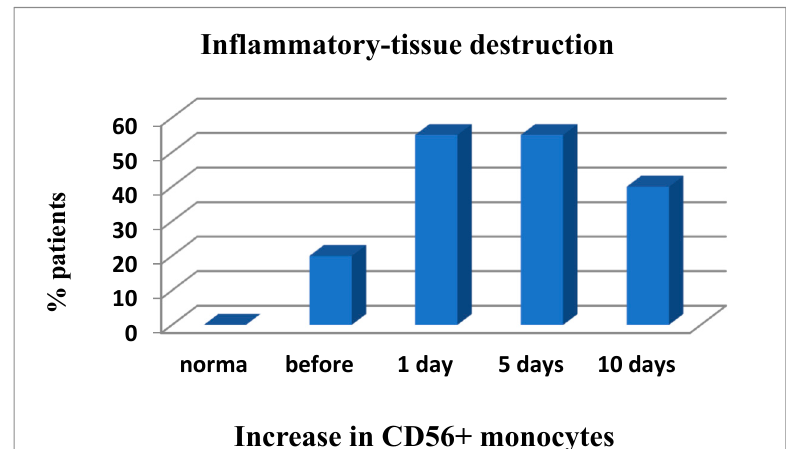
Figure 4. The development of inflammatory-destructive tissue damage in patients reflects an increase in CD56 + Mn. Number of days = after operation.